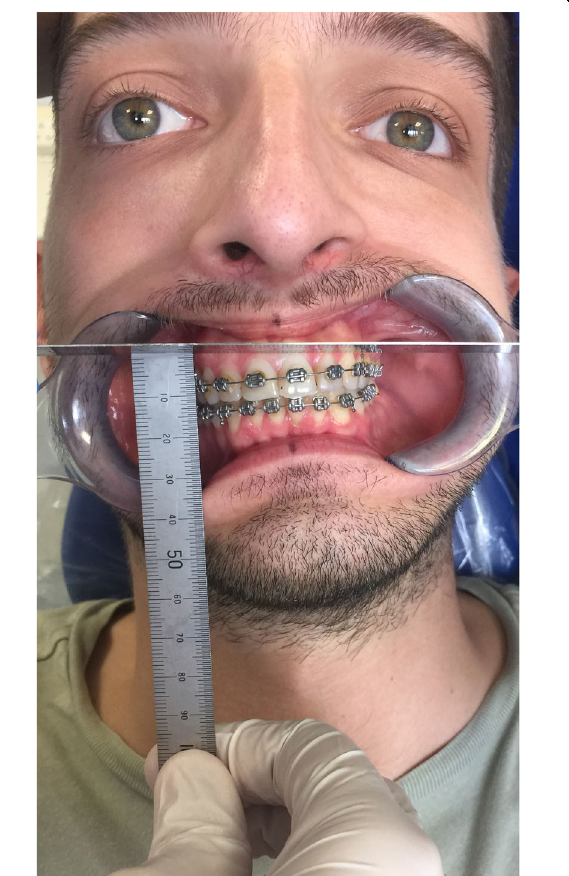
Fig. 3 The flat under-surface of the horizontal part of the measuring instrument is placed on the higher maxillary canine orthodontic bracket hook (though it may be placed on a unilateral segment of any bilateral structure), and held perpendicular to the true vertical. For patients with a relatively symmetrical upper face, and no vertical orbital dystopia, the horizontal part of the measuring instrument may be held approximately parallel to the interpupillary plane (a dental mirror handle may be held in line with the interpupillary plane, to aid visualisation at the chair side). The vertical ruler is held next to the contralateral canine tooth, and the vertical distance measured directly from the canine bracket to the flat under- surface of the horizontal part of the measuring instrument. This vertical distance quantifies the overall extent of movement required to level the maxillary occlusal seated upright in the dental chair, the horizontal part of the instrument may be held parallel to the interpupillary line, assuming no vertical orbital dystopia is evident. It is worth emphasising that the instrument may be held relative to a true vertical plumb line hanging from the ceiling if a patient has a severe craniofacial asym- metry and vertical orbital dystopia. However, this is usu- ally not the case in orthognathic patients, and we suggest that when the interpupillary line is essentially parallel (i.e. the absence of vertical orbital dystopia), then the horizontal part of the instrument may be help paral- lel to the interpupillary line.